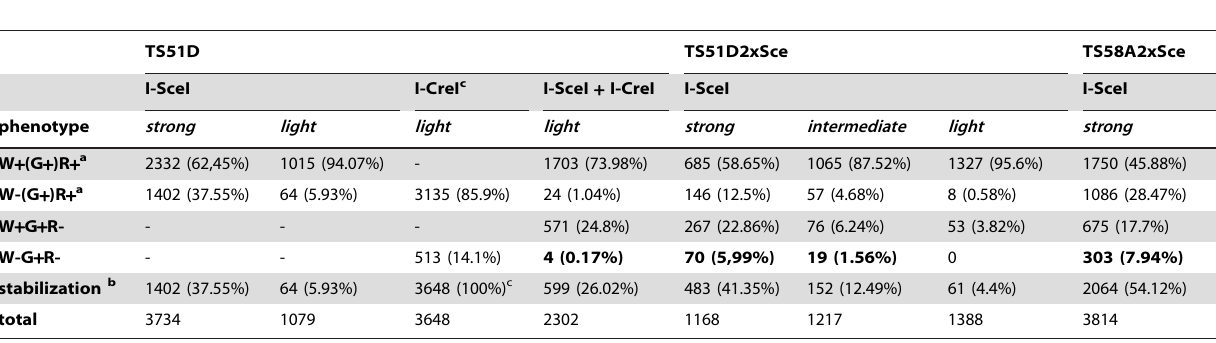
Table 1. Stability of TS51D, TS51D2xSce and TS58A2xSce transgene vectors at DSBs induction under different heat shock delivery as indicated by absence or presence of marker